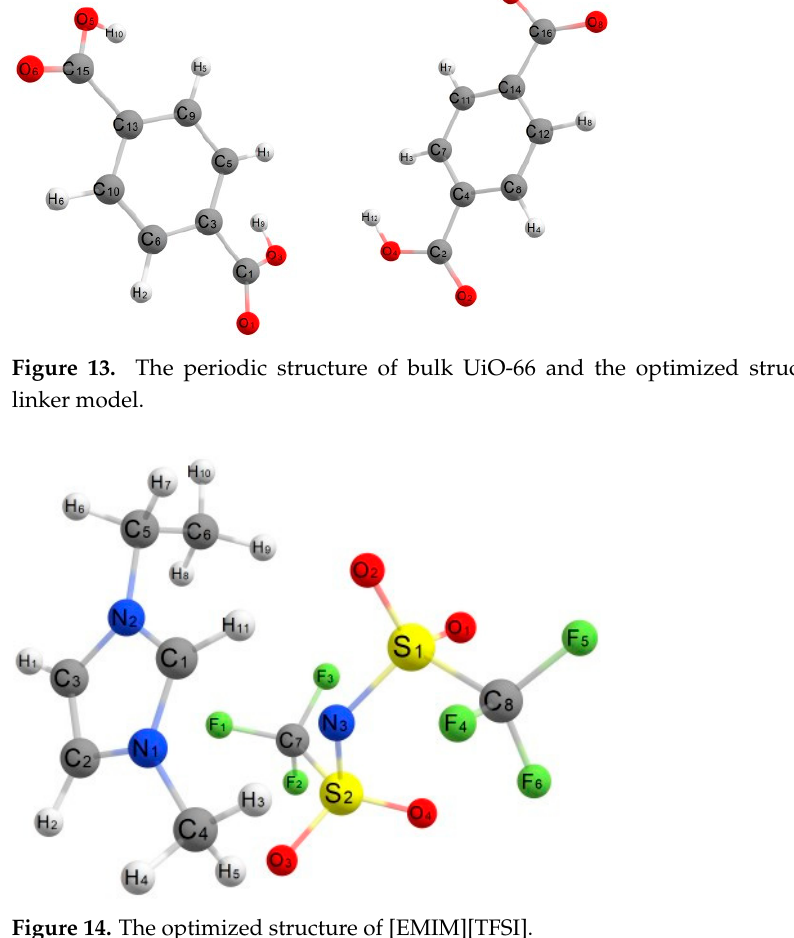
Figure 14. The optimized structure of [EMIM][TFSI].